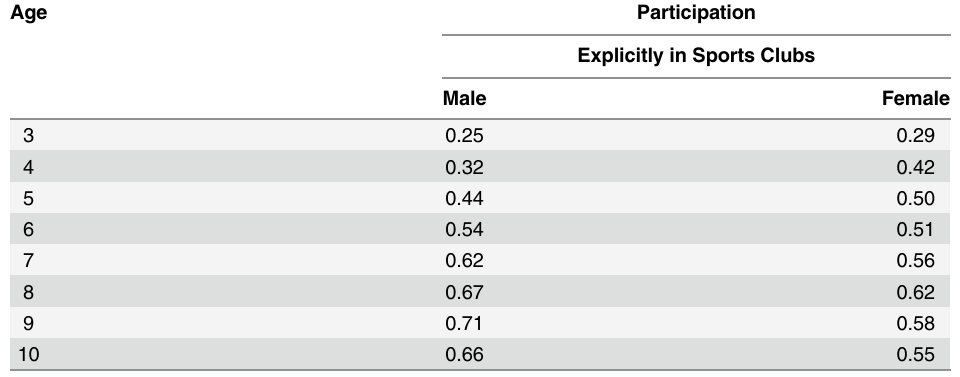
Table 1. Participation in sports clubs. Note: The numbers presented above are based on our own calcula- tions using the KiGGS data. They represent the share of children in each age group reporting attending a sports club at least once per